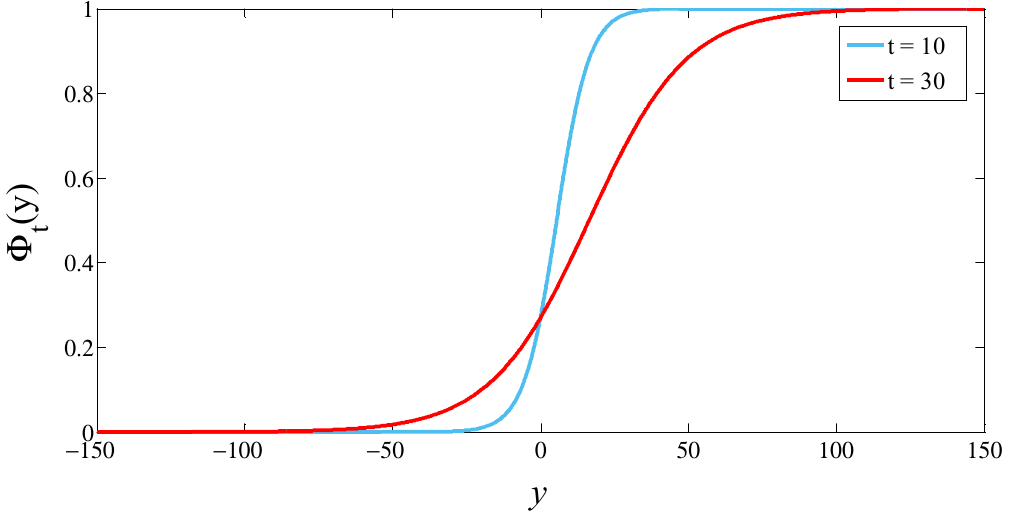
y Φ of Liu process t ( y ) of Liu process C t t